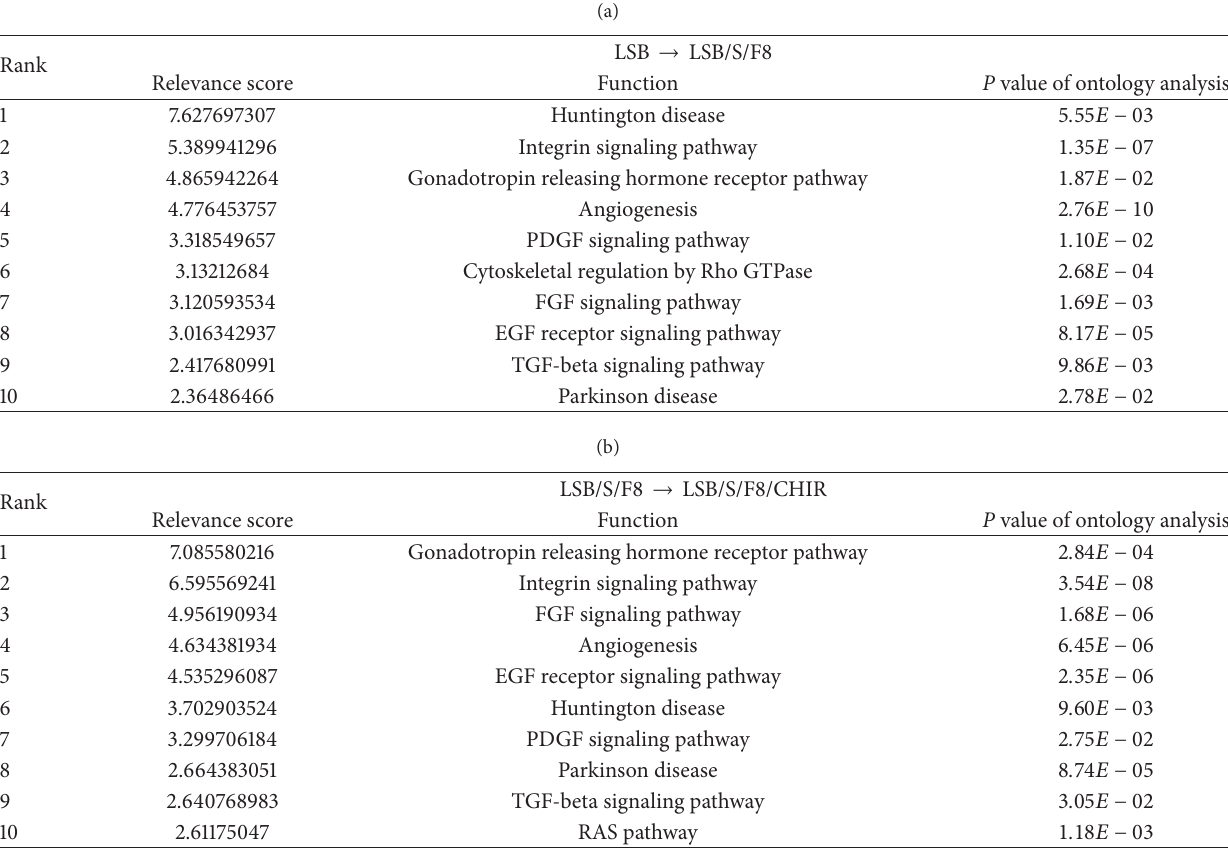
Table 2: (a) The ten functions highest in relevance score from the LSB to LSB/S/F8 condition. (b) The ten functions highest in relevance score from the LSB/S/F8 to LSB/S/F8/CHIR